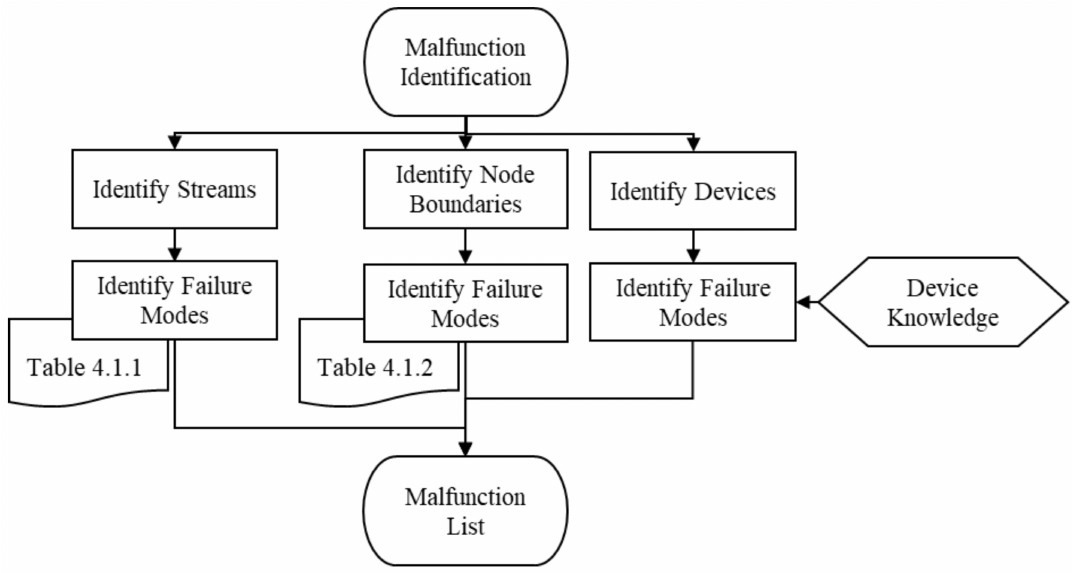
Figure 4. Systematic approach for device malfunction